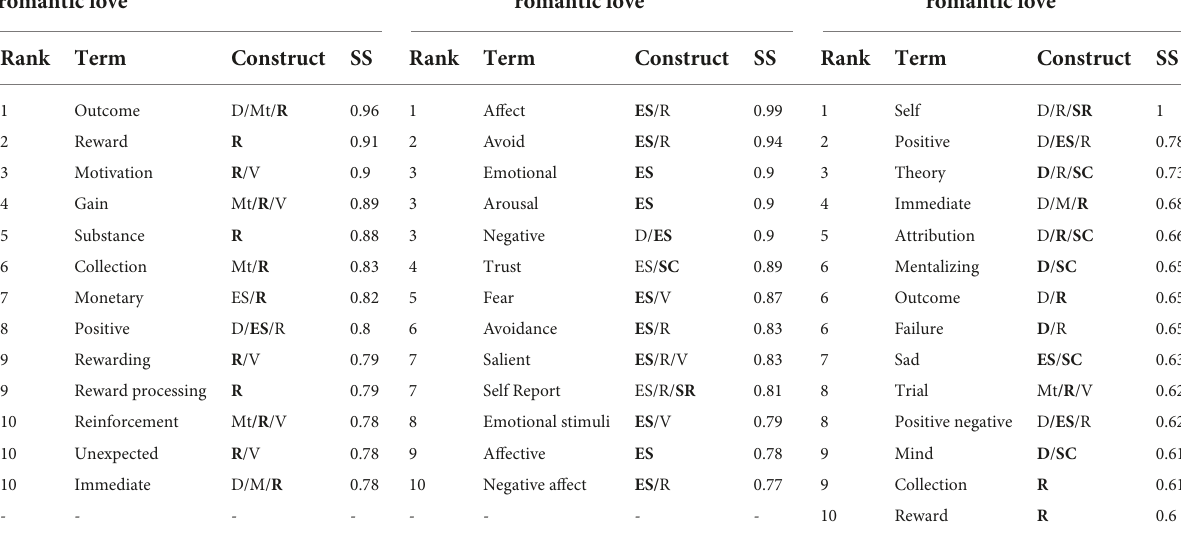
TABLE 1 Decoded results (early stage phase).